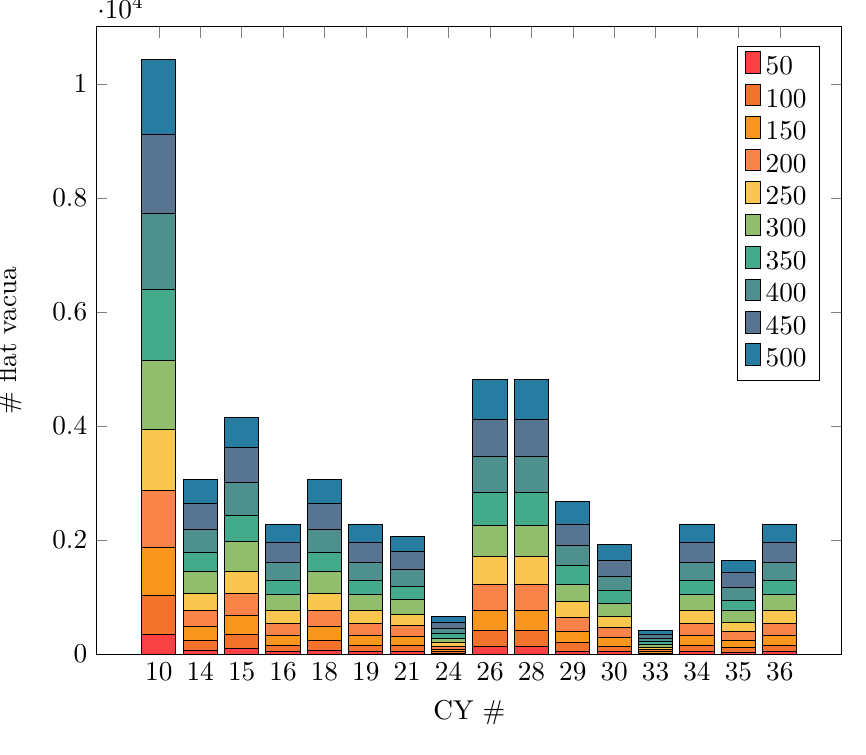
Figure 1. Statistics of PFFV for K3-fibered models. Here different colors presenting the PFFV numbers for each of the CY space correspond to N